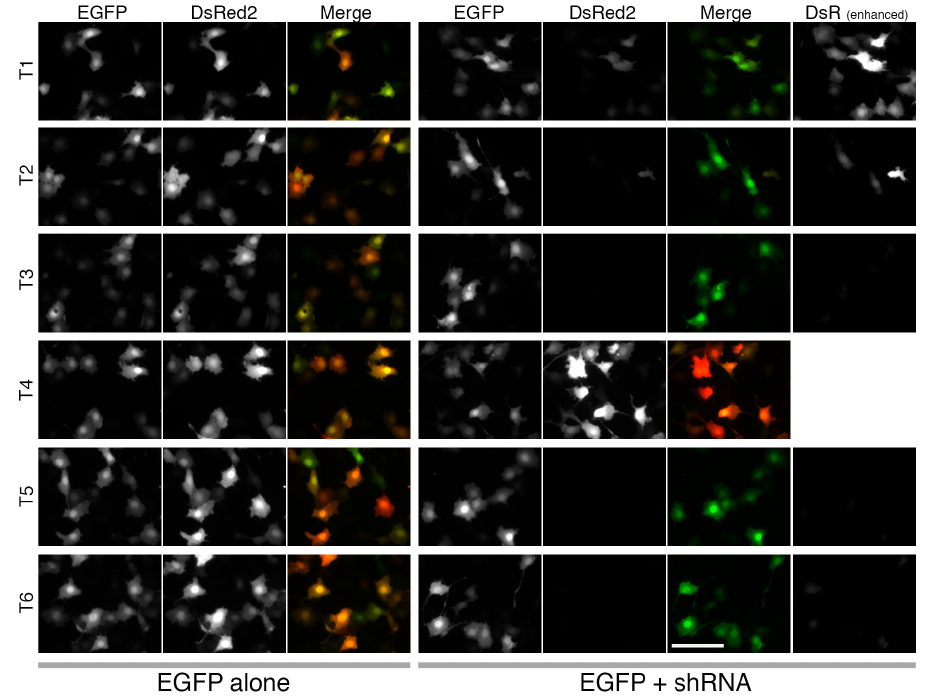
Supplemental Figure 3. Dual fluorescence assay of vimentin shRNA efficacy. Rat2 cells were transfected with combinations of either pSHIN-G empty vector plus pREFLECT-R(DsR)-Vim (EGFP alone) or pSHIN-G-Vim plus pREFLECT-R(DsR)-Vim (EGFP + shRNA). Two days afterwards, fixed cells were observed by fluorescence microscopy. In the merged images, EGFP and DsRed2 fluorescence are show as green and red colors. The reduction of red fluorescence differed dependent on the target sequences. Bar, 100